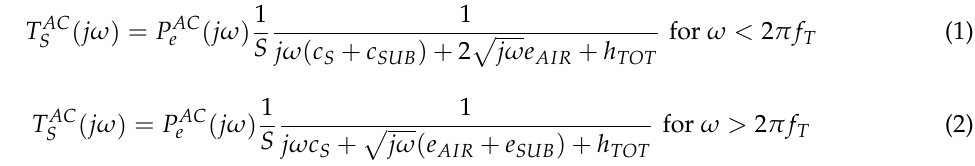
Figure 5. Experimental (coloured symbols) and simulated (black solid line) acoustic frequency responses (power to pressure) normalized at 1m distance of the TA loudspeaker samples: ( a ) Kapton substrate; ( b ) glass substrate.